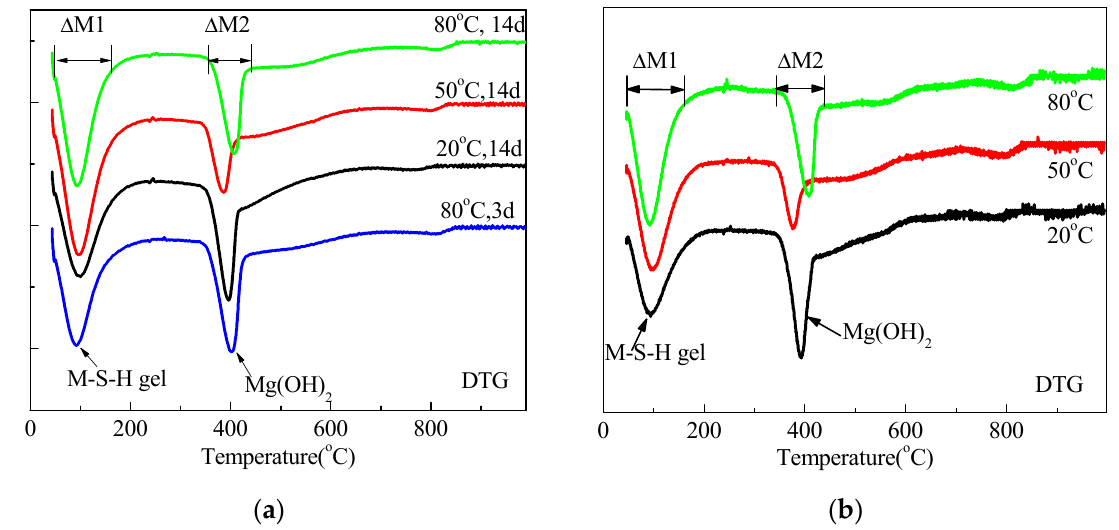
Figure 11. DTG curves of MgO-SF pastes using MgO calcined at 1450 °C for 30 min; ( a ) cured for 3 d and 14 d and ( b ) cured for 28 d.